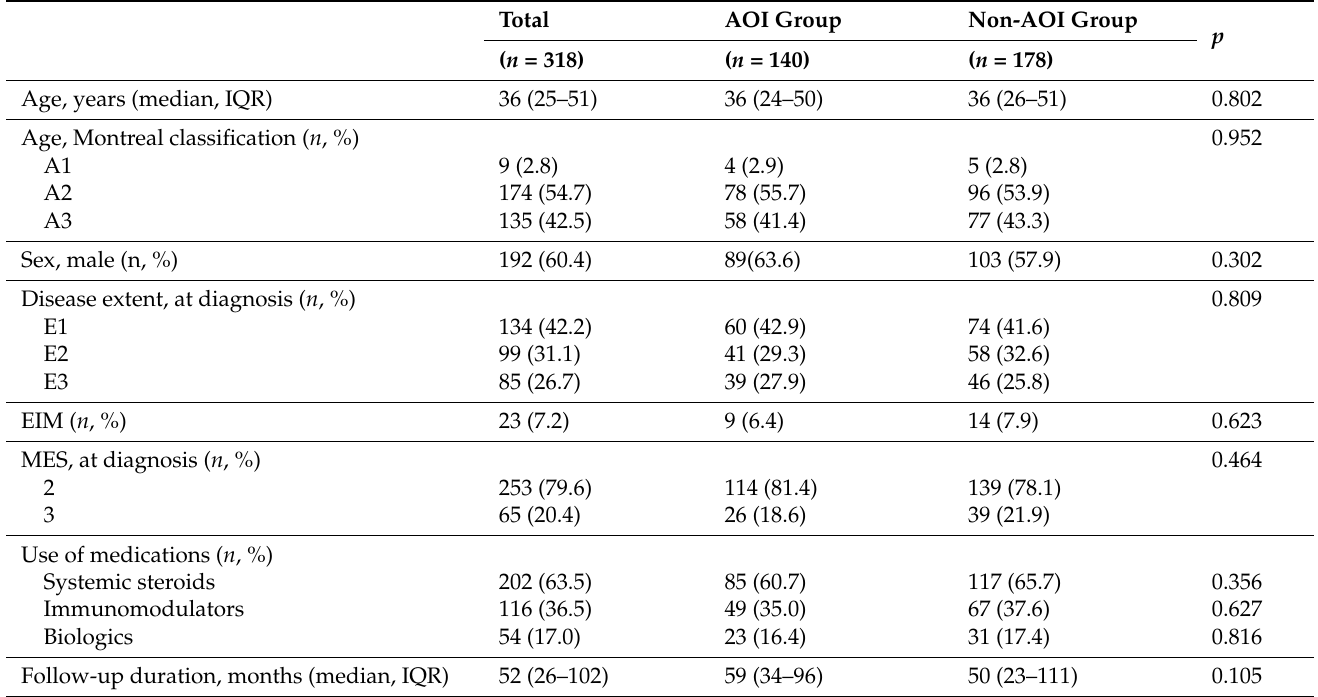
Table 1. Baseline characteristics according to appendiceal orifice inflammation. Total AOI